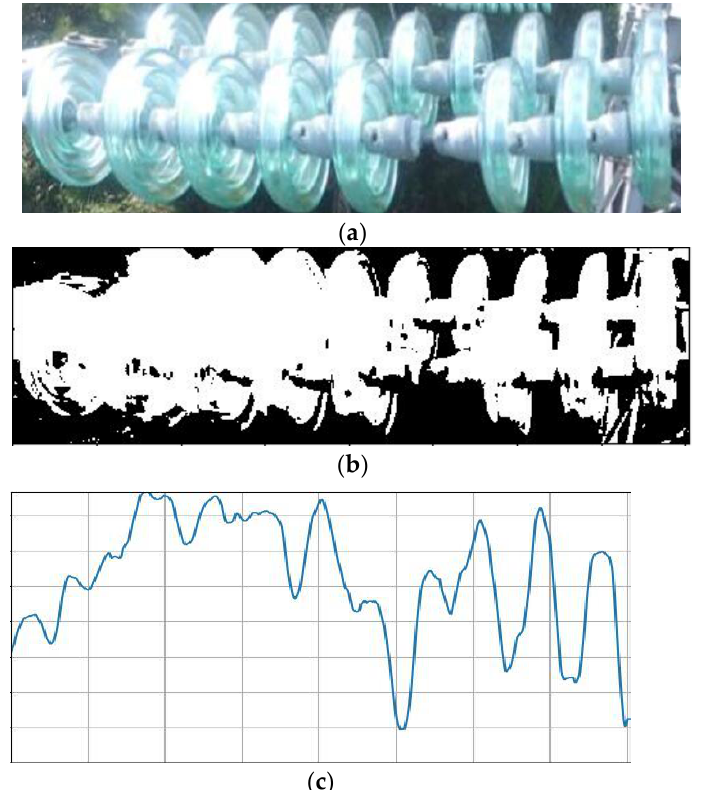
Figure 15. Influence of shooting angle. ( a ) Insulator with the shooting angle to the right, ( b ) binary graph with unsatisfactory insulator segmentation effect, ( c ) pixel statistical chart of the insulator (the segmentation effect is not ideal).